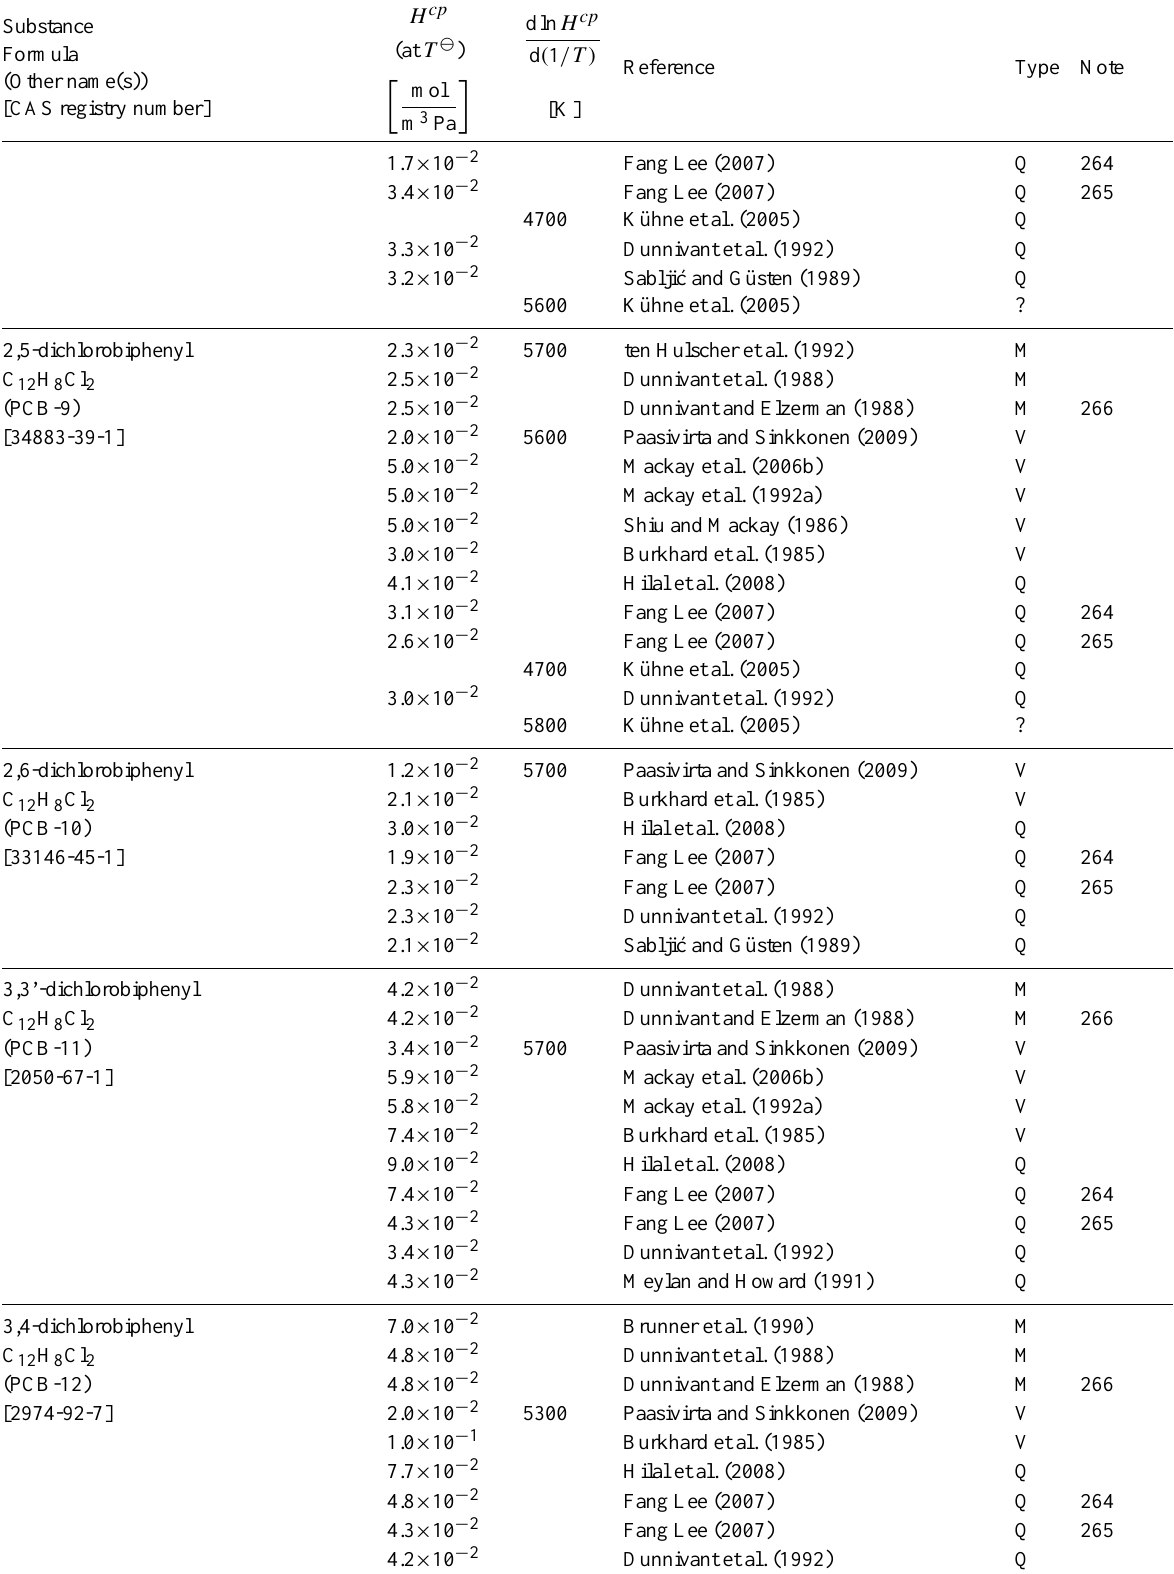
Table 6: Henry’s law constants for water as solvent